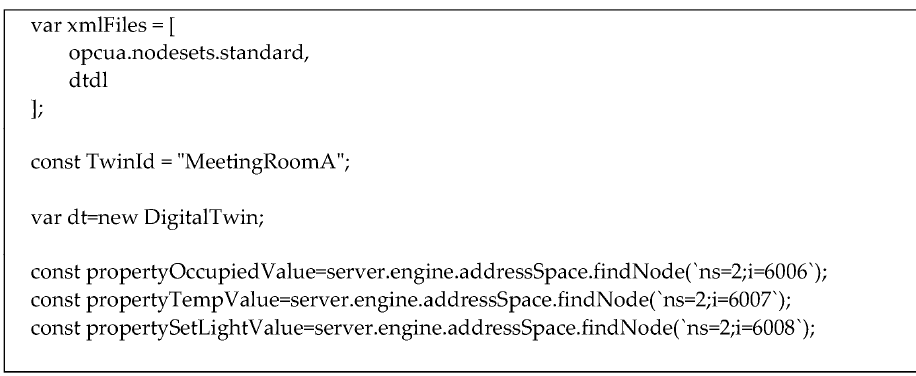
Figure 15. Initializations needed in the OPC UA Server in NodeJS.